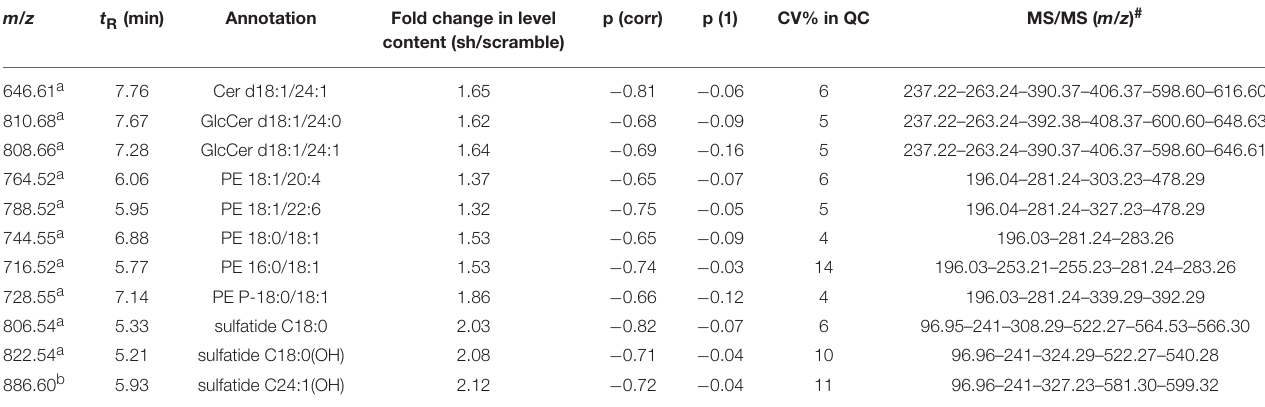
TABLE 2 | Discriminative lipid species whose detected levels in AAV-shCYP46A1 4 weeks after injection are higher than in the control (AAV-scramble) predicted by OPLS-DA obtained from negative ion mode data set.